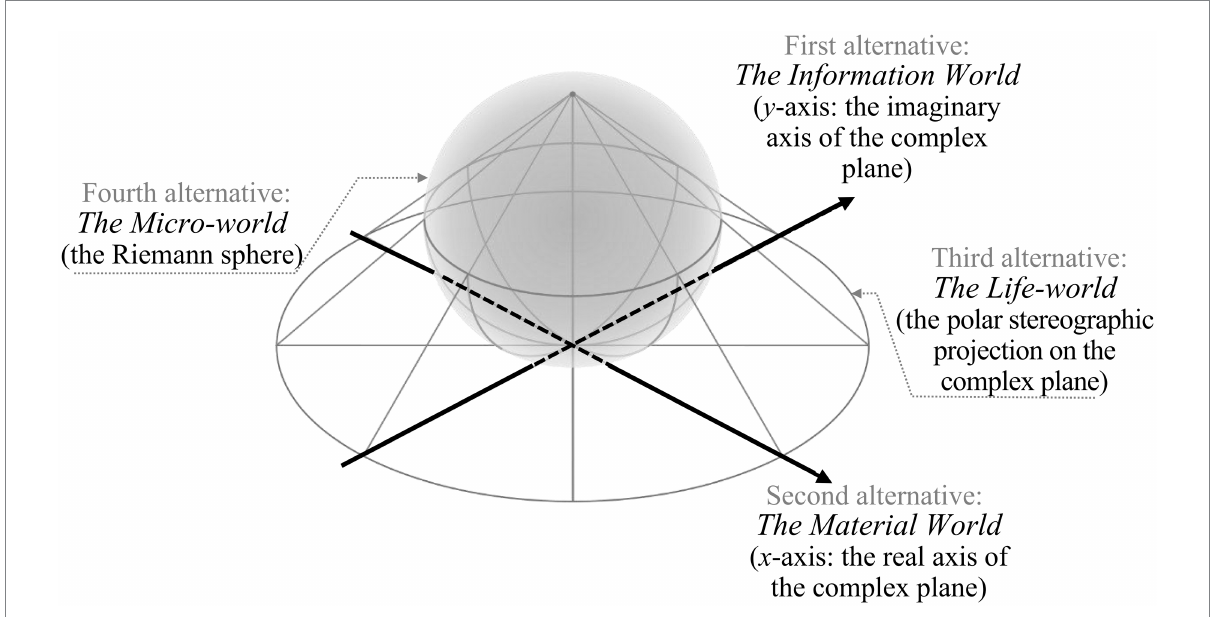
FIGURE 7 The catus ̣ kot ̣ i structure of the quadruple